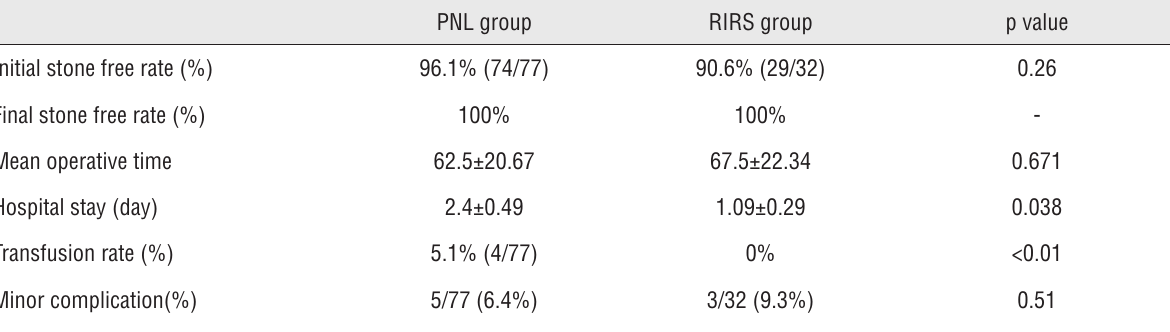
Table 2 - Treatment Results in Both